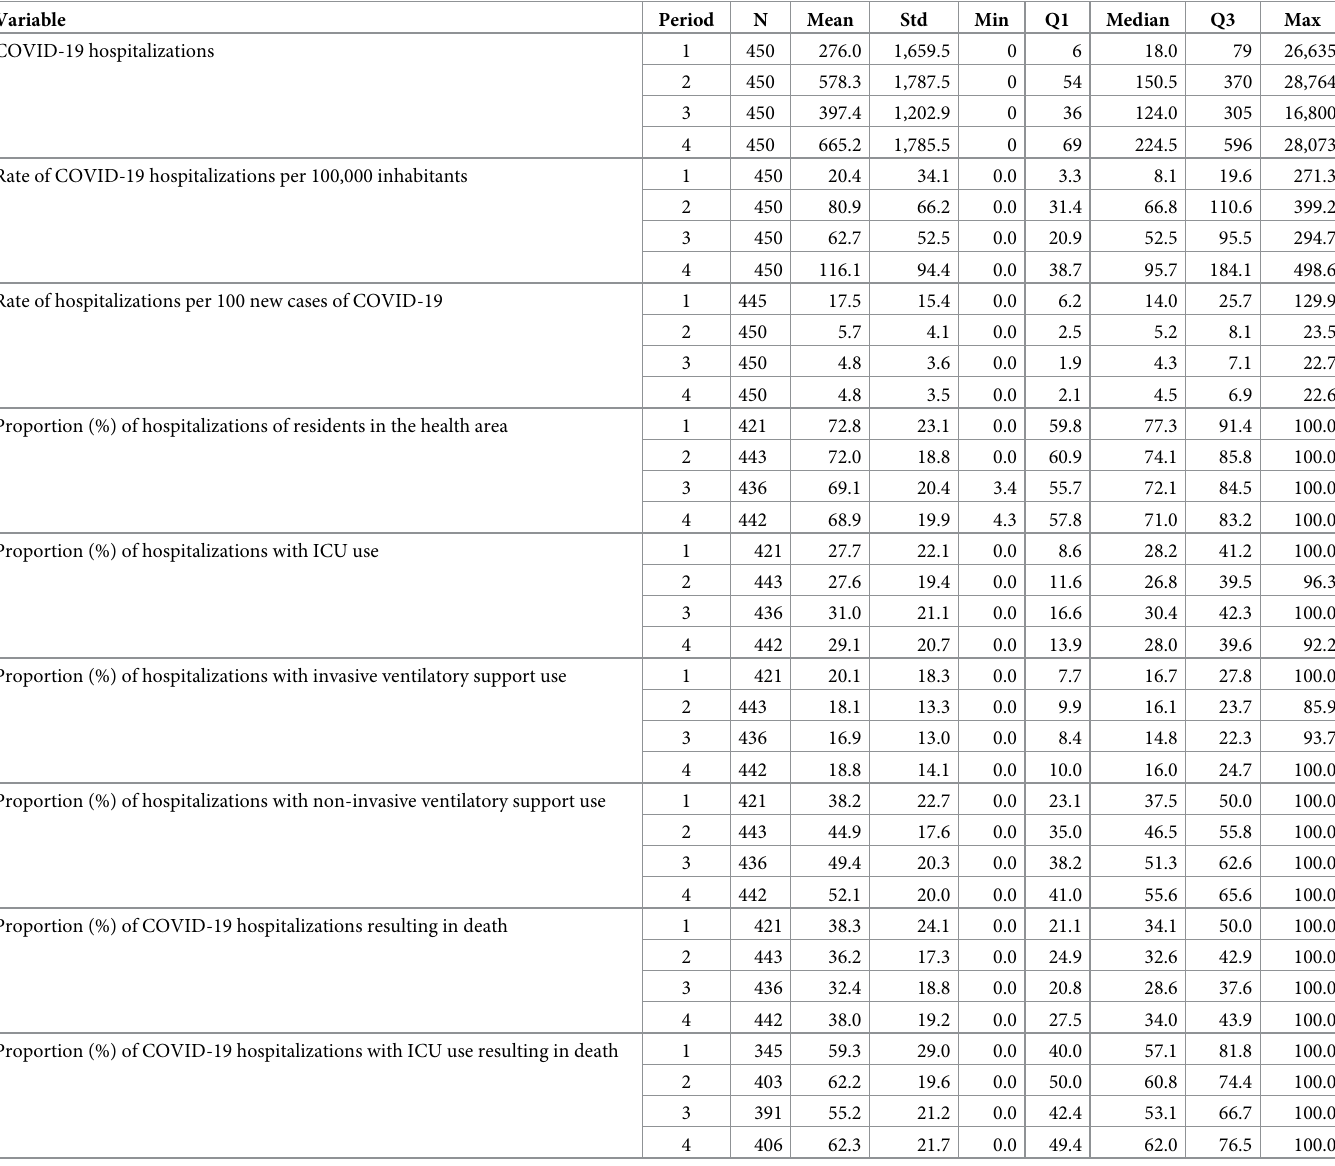
Table 1. Distribution of variables related to the occurrence of COVID-19 hospitalizations and inpatient care process and outcomes in the administrative Health Regions. Brazil, epidemiological weeks 09/2020–11/2021, 23 Feb 2020–20 Mar 2021. Variable